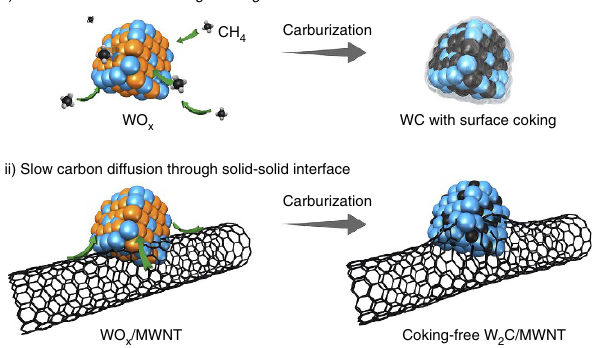
Figure 2 | Schematic illustration showing the influence of different carbon precursors. Gaseous carbon precursor (for example, CH 4 ) and non-volatile solid carbon precursor (for example, CNT) may have different impacts on the chemical composition and microstructure of the carburization